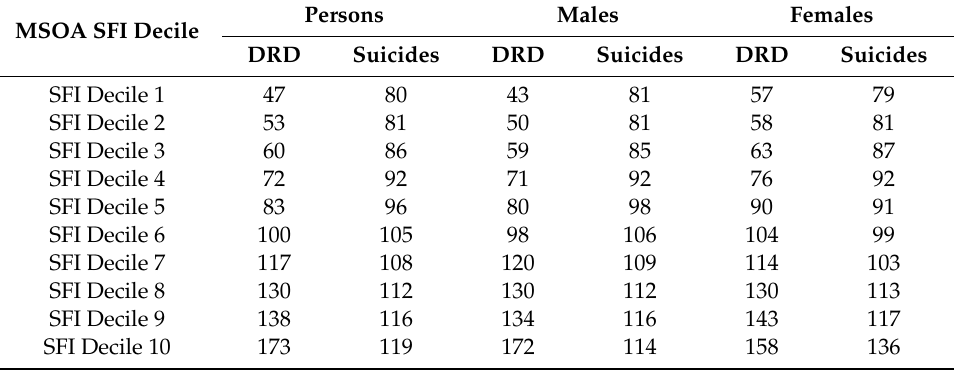
Table 2. Drug-related deaths (DRD) and suicides, standard mortality ratios by MSOA fragmentation decile.